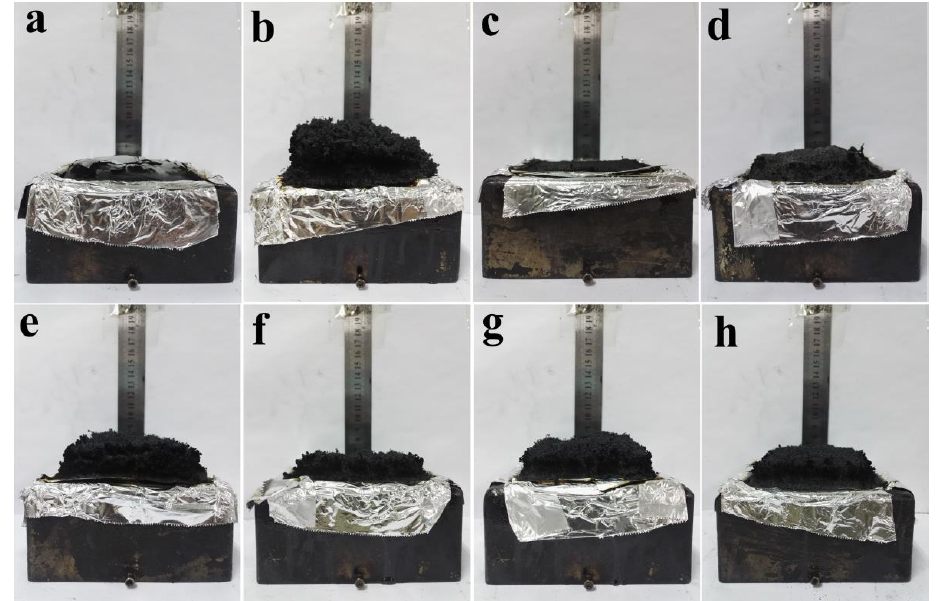
Figure 6. Photos of SSPCM residues after cone calorimeter tests: ( a ) PCM, ( b ) PCM-EG, ( c ) PCM-red phosphorus (RP), ( d ) PCM-intumescent flame retardant (IFR), ( e ) PCM-EG / RP (3 / 1), ( f ) PCM-EG /